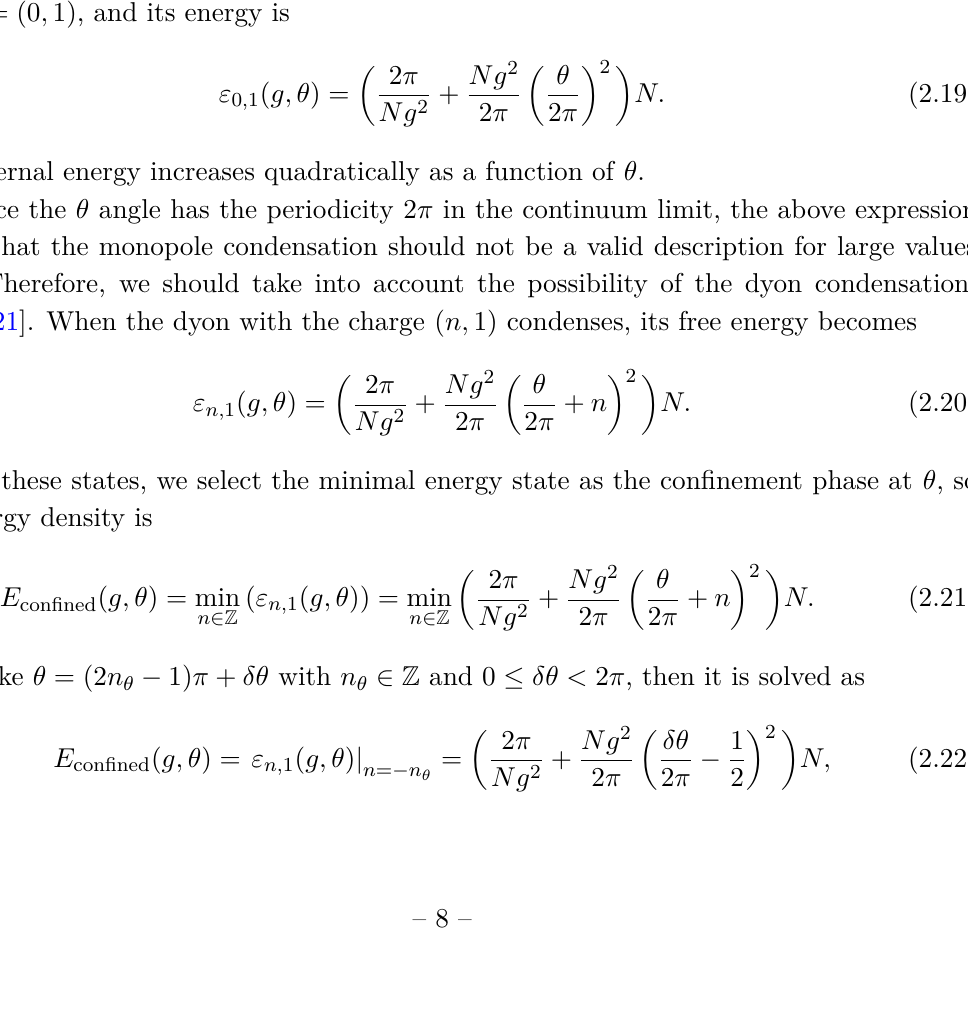
Figure 2 . Phase diagrams for 0 < θ < 2 π and Ng 2 / 2 π < 5 when C/N > 2 / √ C/N < 2 / 3 (right) based on the simple free energy argument. In the right figure, the Coulomb phase appears in the gray regions denoted by γ . The weak coupling region is governed by the Higgs phase, while the strong coupling region by the confinement phase. For 0 < θ < π , the confinement is caused by the condensation of the monopole, ( n, m ) = (0 , 1) , while for π < θ < 2 π , it is caused by the condensation of the dyon, ( n, m ) = ( − 1 , 1) . For sufficiently strong coupling, Ng 2 / 2 π > 2 the oblique confinement mode appears near θ = π , which is the condensation of ( n, m ) = ( − 1 , 2) . Blue solid curves separate these gapped phases by the phase